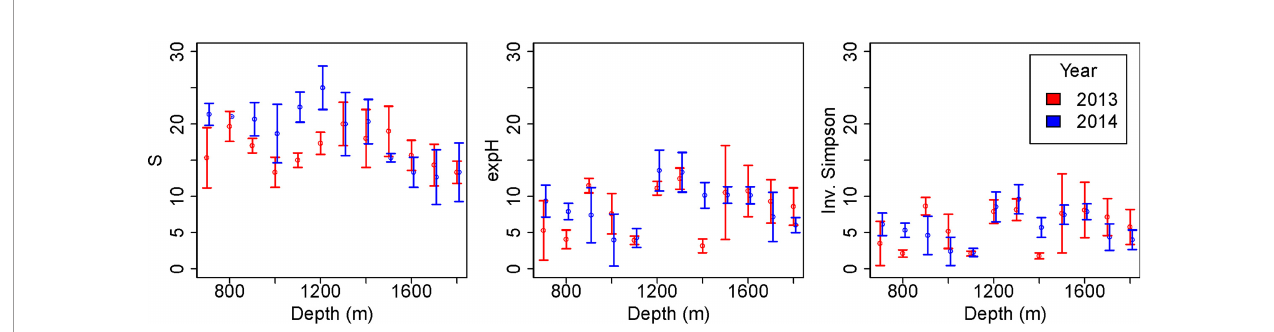
FIGURE 6 | Diversity variation with depth before (2013) and after (2014) pipeline installation. Error bars represent standard deviations. Diversity measured as species richness (S), exponential Shannon index (expH) and inverse Simpson index (Inv. Simpson) following Hill (Hill, 1973).